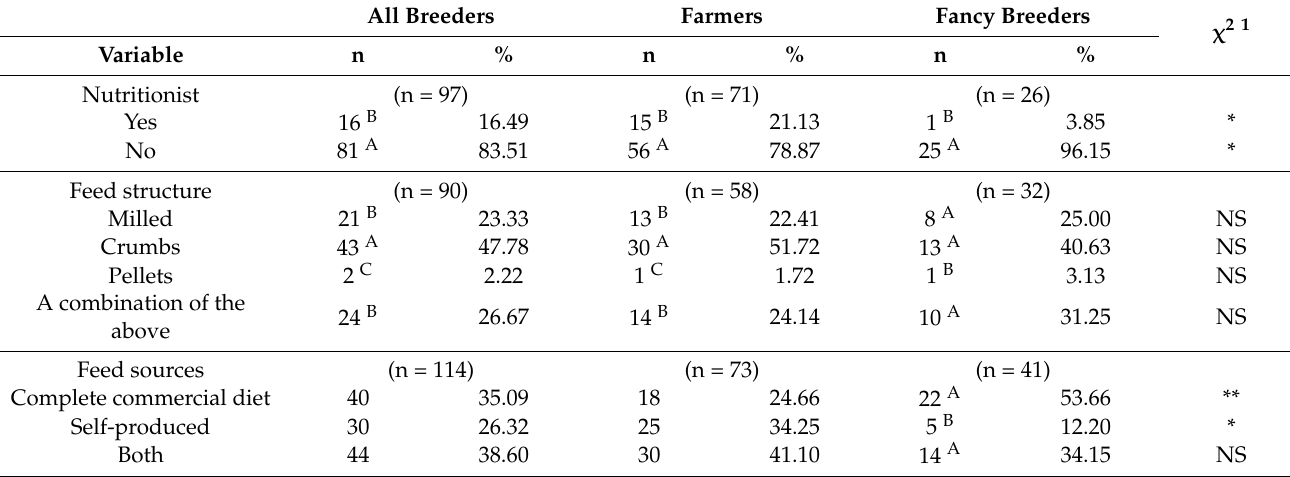
Table 10. Professional nutrition assistance, feed structures and feed sources: responses from all breeders and divided according to breeder